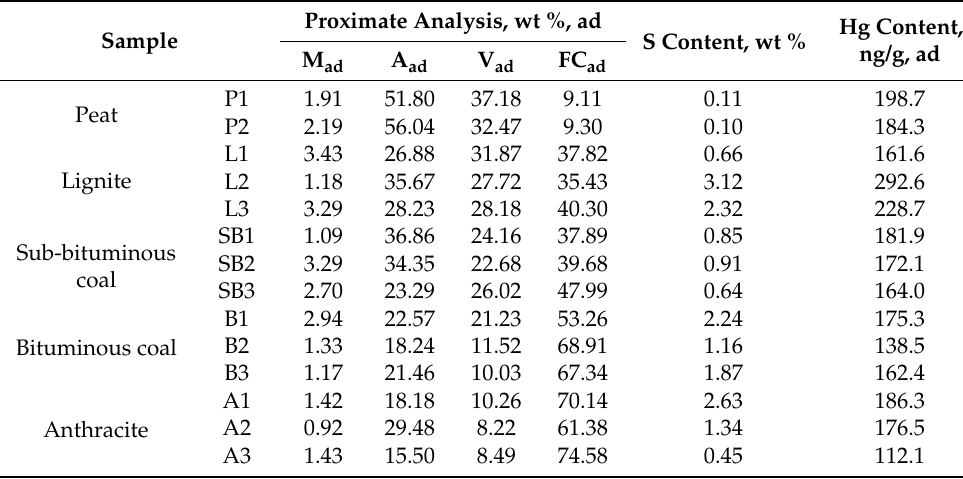
Table 1. Proximate analysis and Hg content of samples (wt